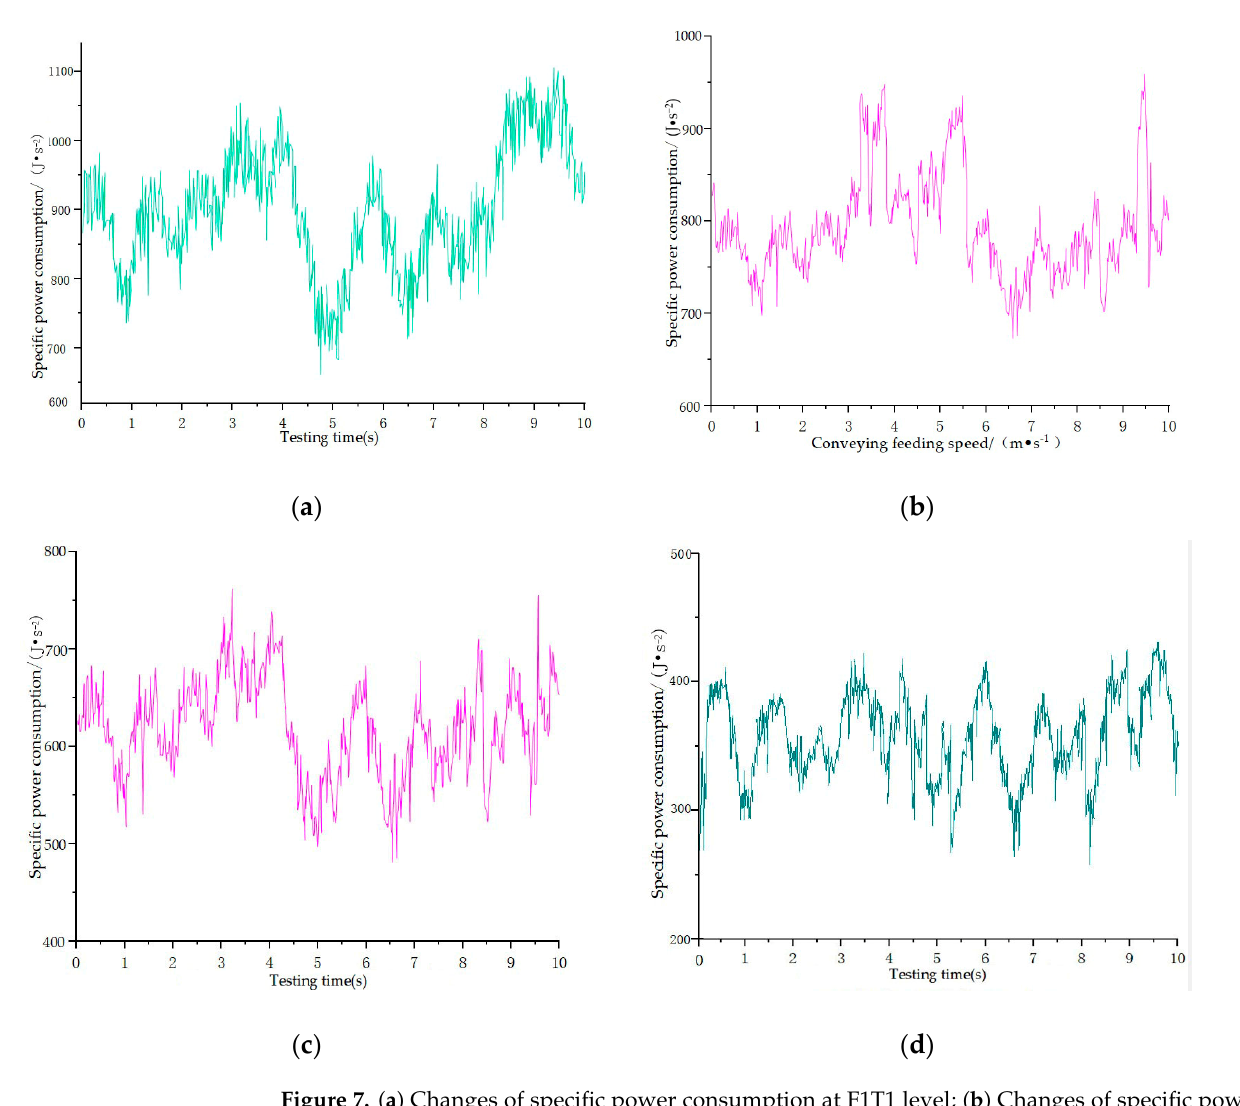
Figure 7. ( a ) Changes of specific power consumption at F1T1 level; ( b ) Changes of specific power consumption at F1T2 level; ( c ) Changes of specific power consumption at F1T3 level; ( d ) Changes of specific power consumption at F1T4 level.